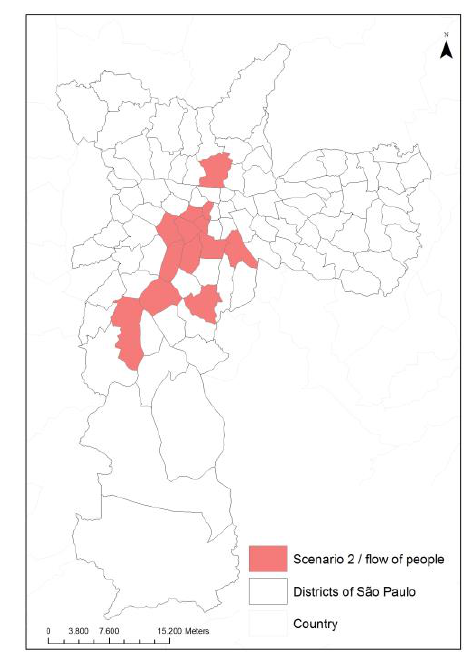
Figure 13. Intersection of the three scenarios: candidate districts to receive the carsharing stations. (Source: